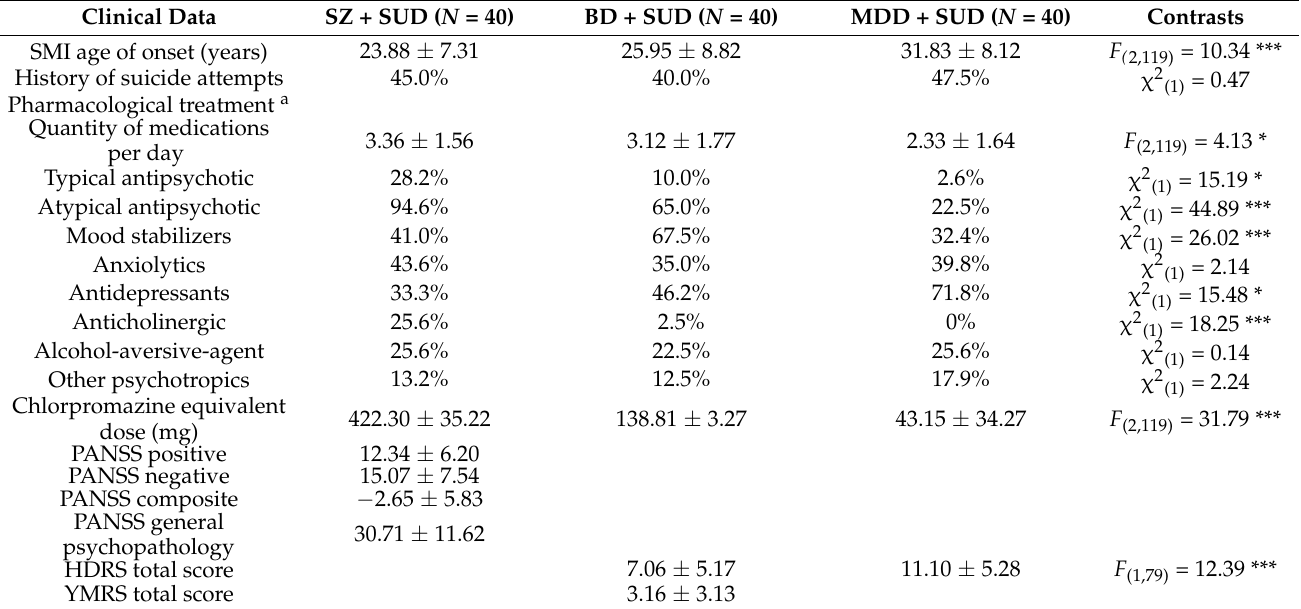
Table 2. Clinical data for the three groups of patients regarding psychiatric diagnosis. Means, standard deviation, percentages and statistical contrasts (ANOVA and chi-square